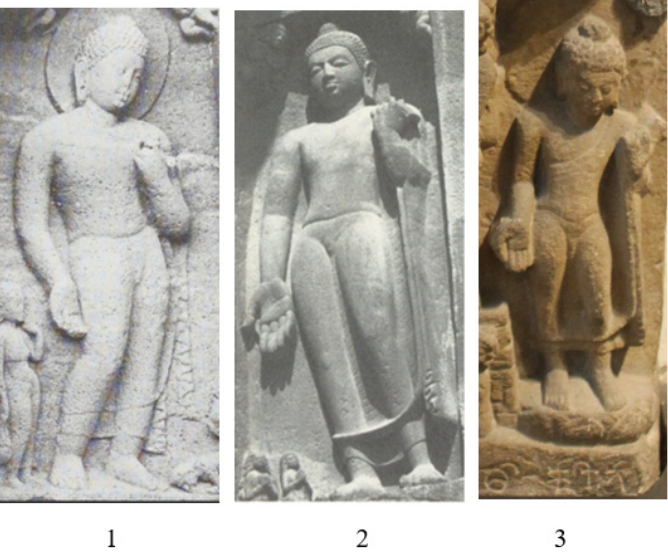
Figure 6. Standing Buddhas with diaphanous robe covering only the left shoulder (type C) in India. (1): Buddha of the Façade to left of door, Cave 19. Ajanta, north-central Maharashtra state, India, late 5th century (source: Huntington 1985, figure 12.4); (2): Buddha of the Façade,